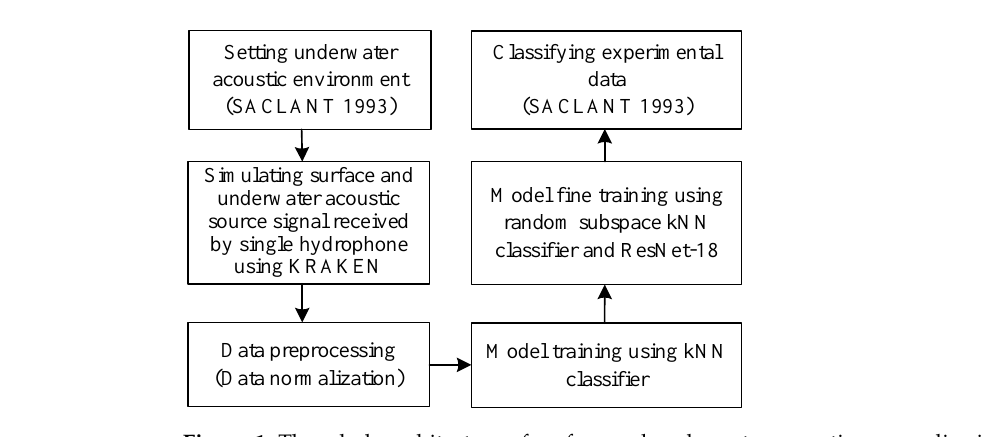
Figure 1. The whole architecture of surface and underwater acoustic source discrimination based on machine learning using only a single hydrophone .